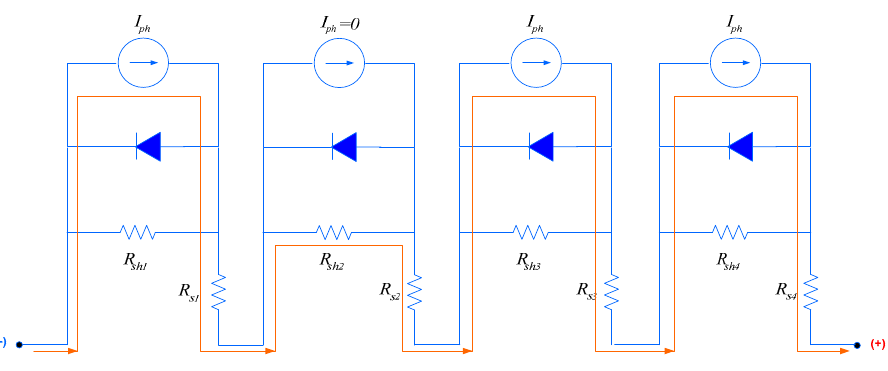
Figure 9. Current circulation when partial shading occurs.